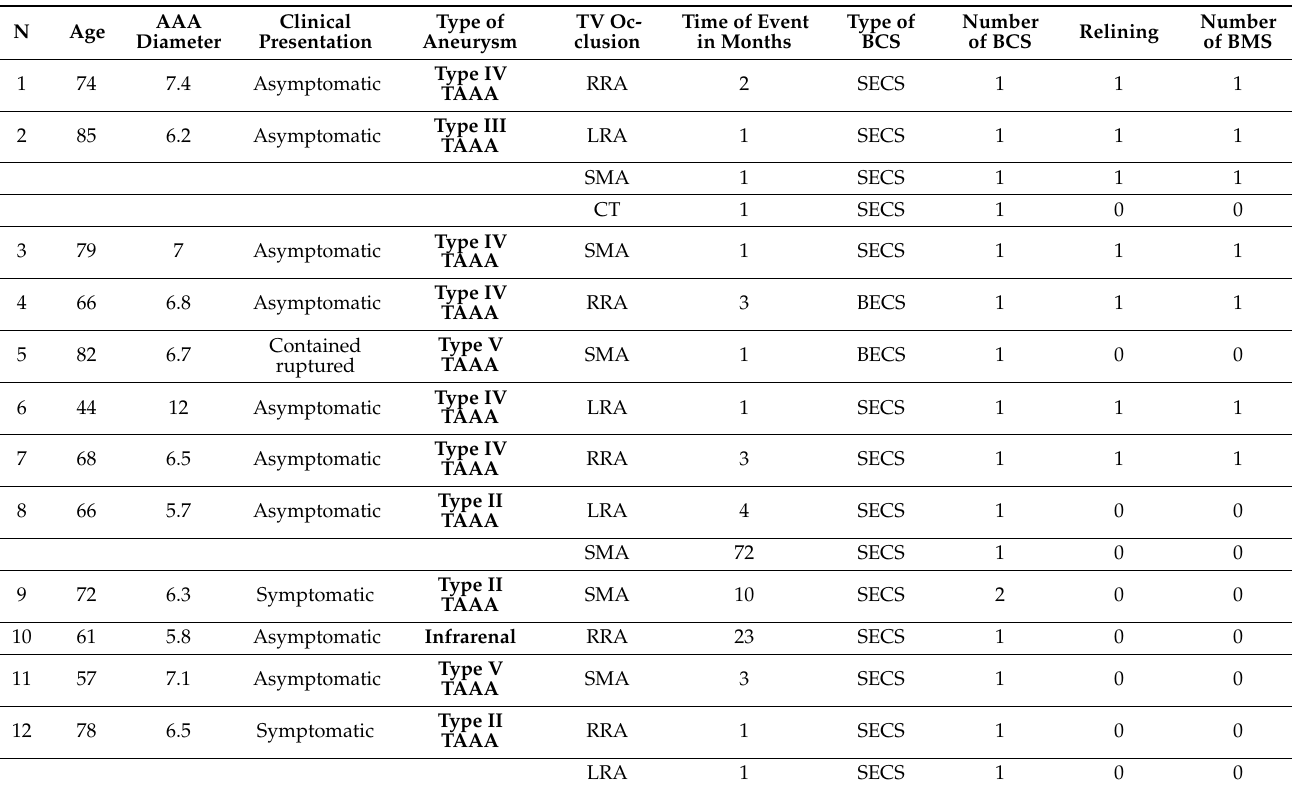
Table 4. Description of patients with loss of patency in one or more target vessels. AAA: abdominal aortic aneurysm; TAAA: thoraco-abdominal aortic aneurysm; BCS: bridging covered stents; BECS: balloon-expandable covered stent; SECS: self-expanding covered